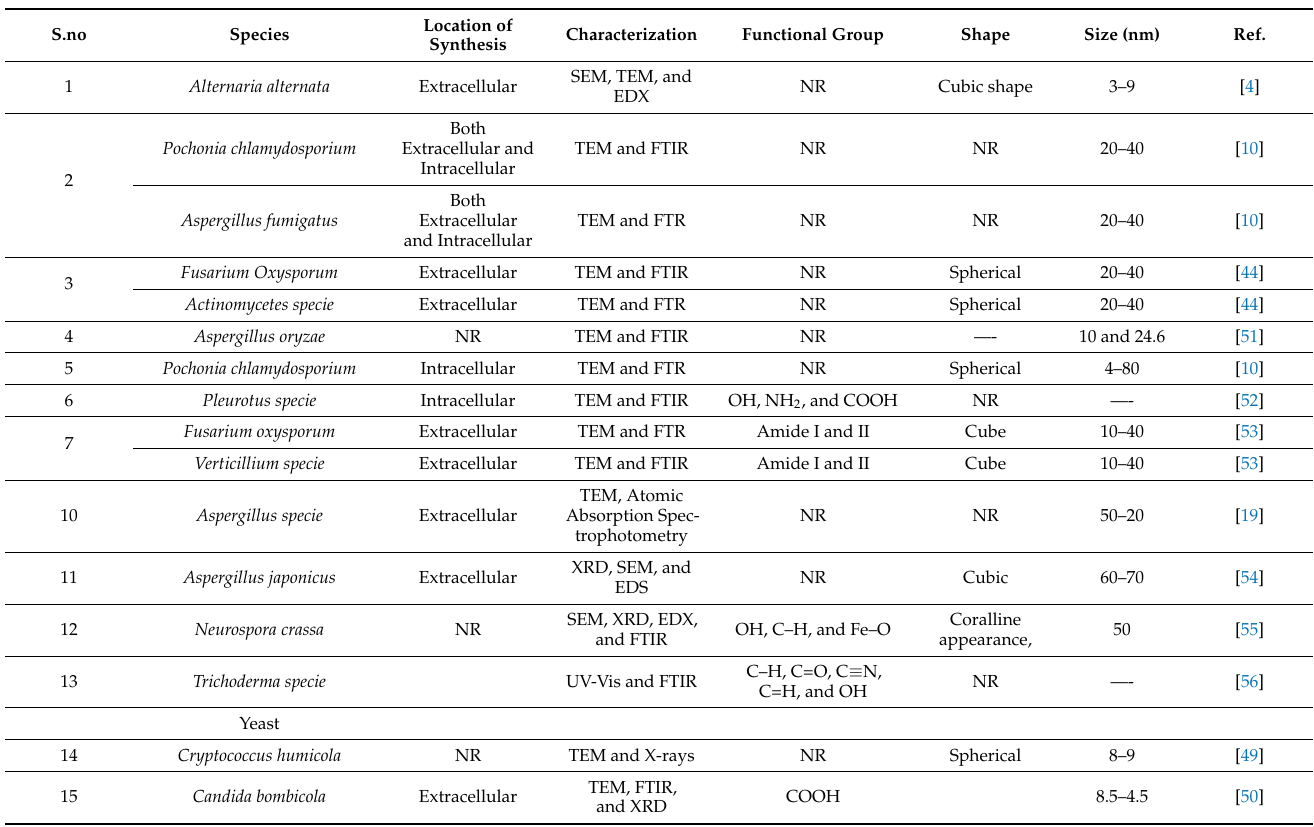
Table 2. Fungus/yeast mediated iron